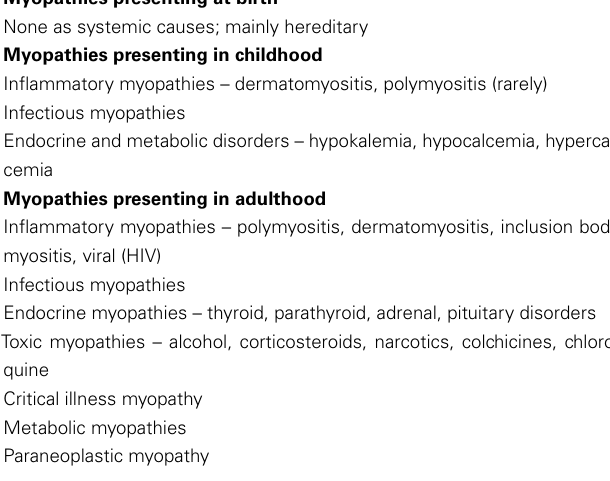
Table 6 | Differential diagnosis of systemic myopathy based on age of